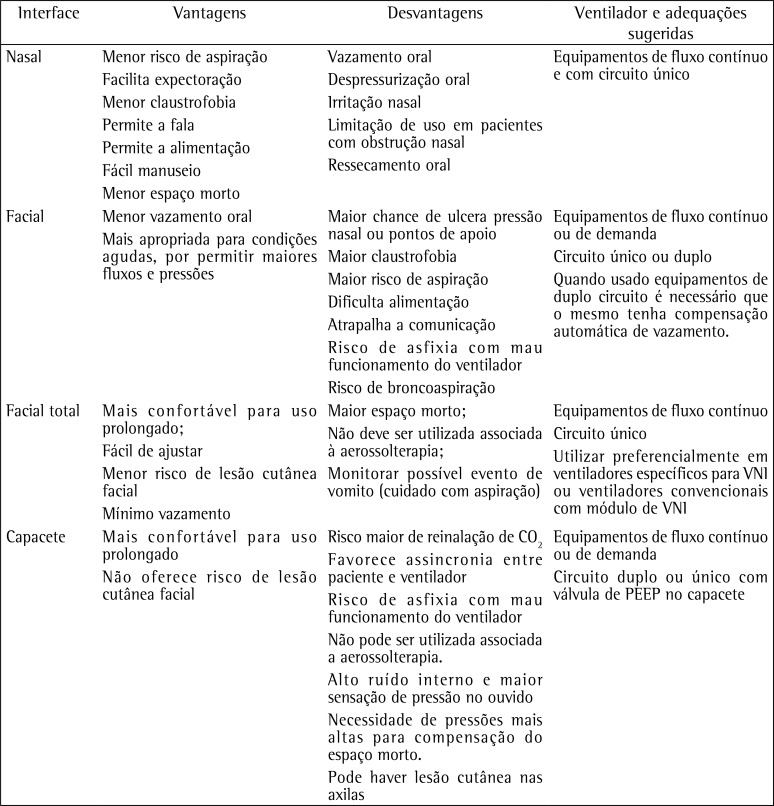
Vantagens e desvantagens dos diversos tipos de interfaces VNI -
ventilação não invasiva; CO2 - dióxido de carbono; PEEP - pressão
expiratória final positiva.